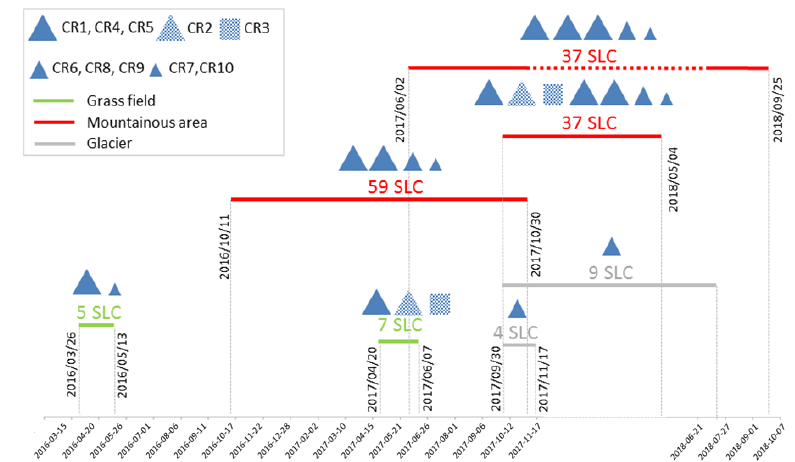
Figure 5. Summary of the number of Sentinel-1 SAR images processed on the Choisy test site (grass field) and the Argentière test site (mountainous area and glacier) with an overview of the use of CRs. The CRs used in each time series are represented by symbols proportional to their